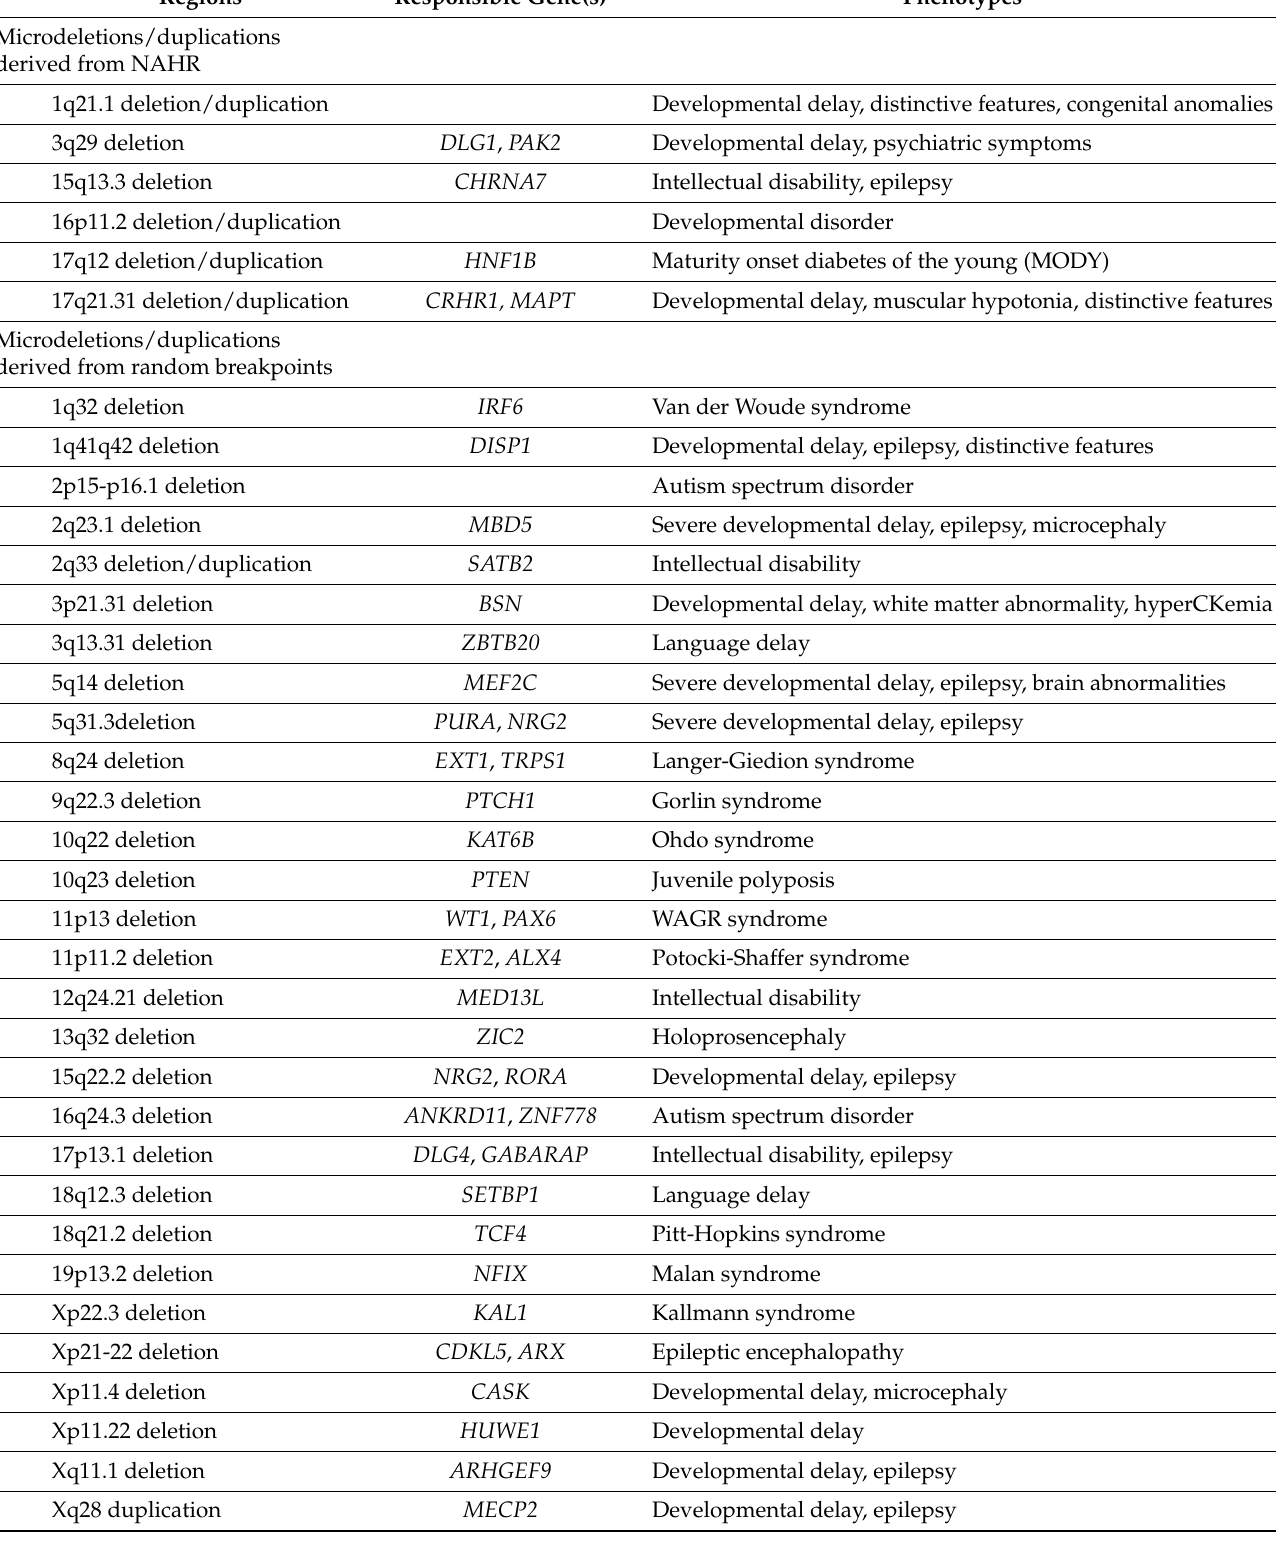
Table 3. Chromosomal regions and